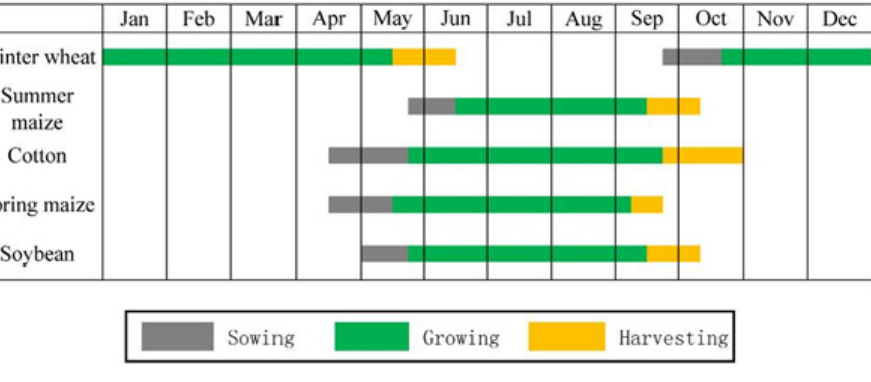
Figure 2. Crop calendars for North China Plain (NCP) areas.